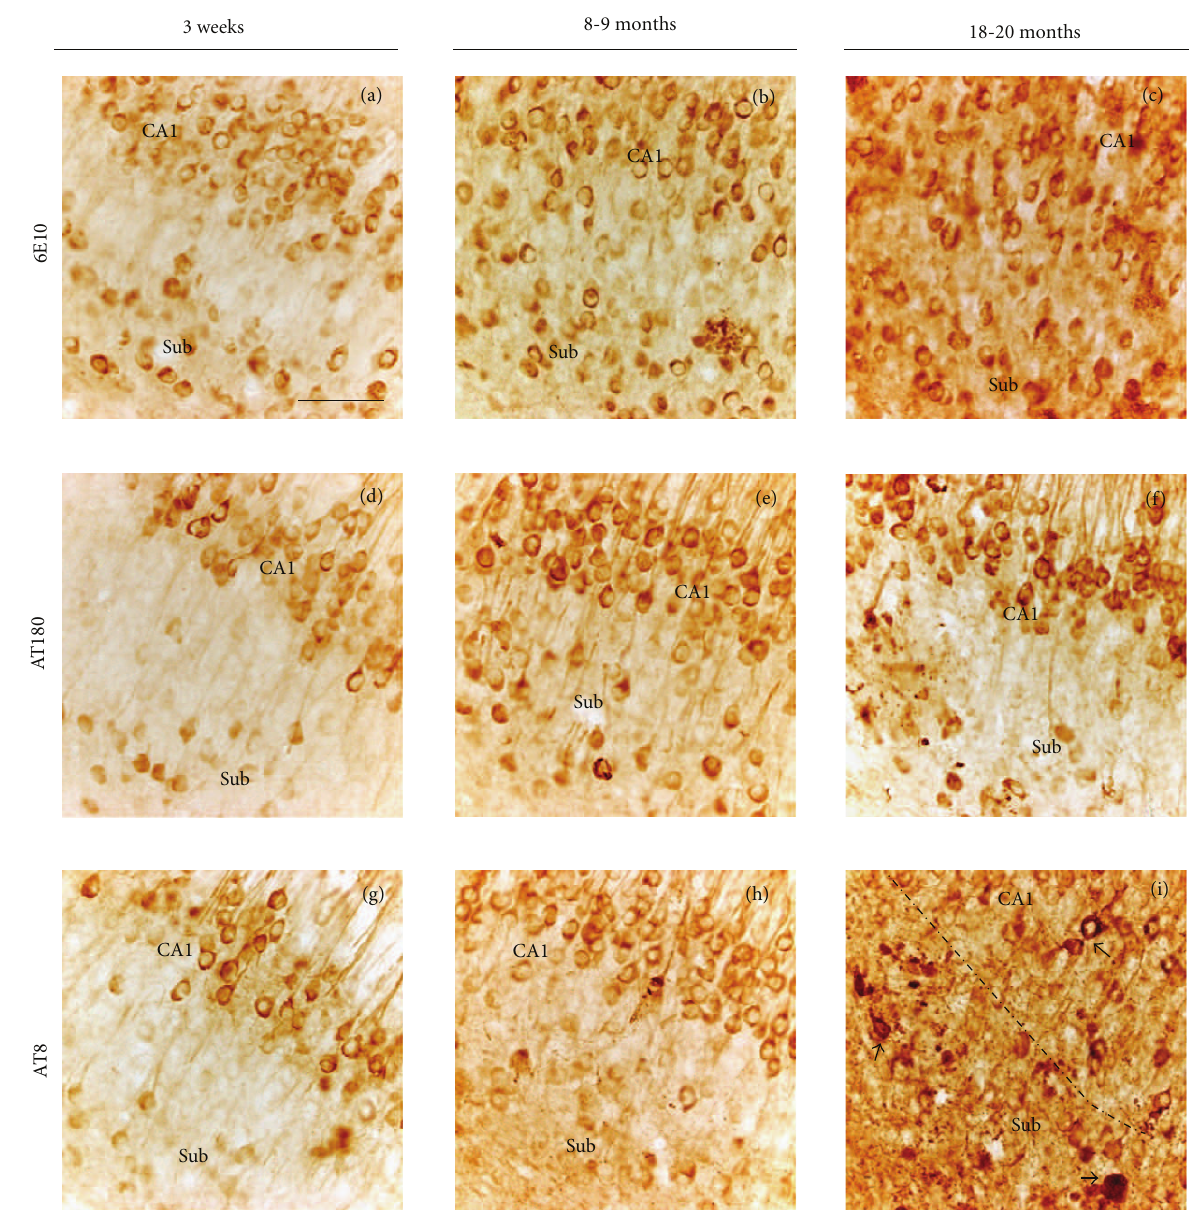
Figure 12: Light microscopic images of adjacent sections showing 6E10, AT180, and AT8 immunoreactive profiles in CA1 and subiculum in 3-week, 9-, and 18–20-months-old 3xTg-AD mice. AT180 and AT8 immunostained CA1 and subicular neurons were present at each age examined. This is in contrast to the Alz50, which only stained neurons in the CA1 field (see Figure 11). The arrows in F and I indicate dystrophic AT8 subicular neurons. Dashed line in (i) demarcates the CA1 field from the subiculum. Scale bar in (a) is the same for all panels = 50 μ